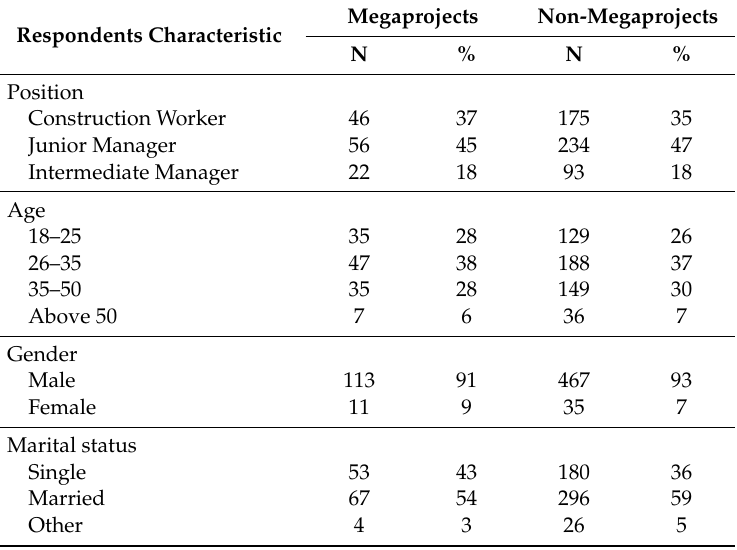
Table 4. Descriptive statistics of the